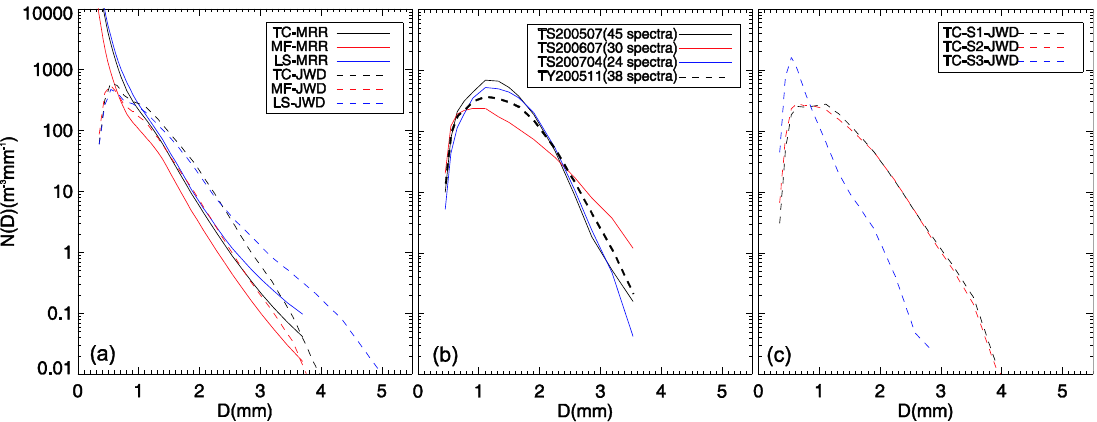
Figure 9. The composite raindrop spectra for ( a ) three rain types based on MRR and JWD (RD80) data, ( b ) the rainfall at 40 dB Z for three tropical storms (TS) and one typhoon (TY) based on JWD data and ( c ) three raining stages of a typhoon event (2005-11) based on JWD data. S1: Stage 1; S2: Stage 2; S3: Stage